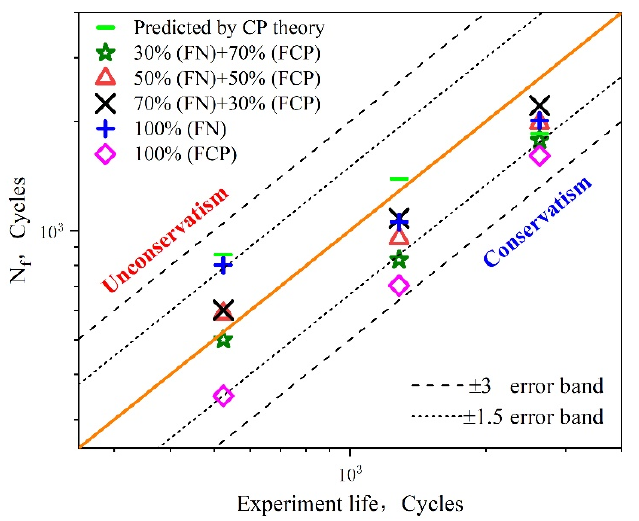
Figure 17. Comparisons between the experiments, predicted results using the proposed method under different probability combinations, and the method based on the crystal plasticity (CP) theory. Table 5. Tested LCF lives of the UFG AA6061 vs. the predicted results considering only one